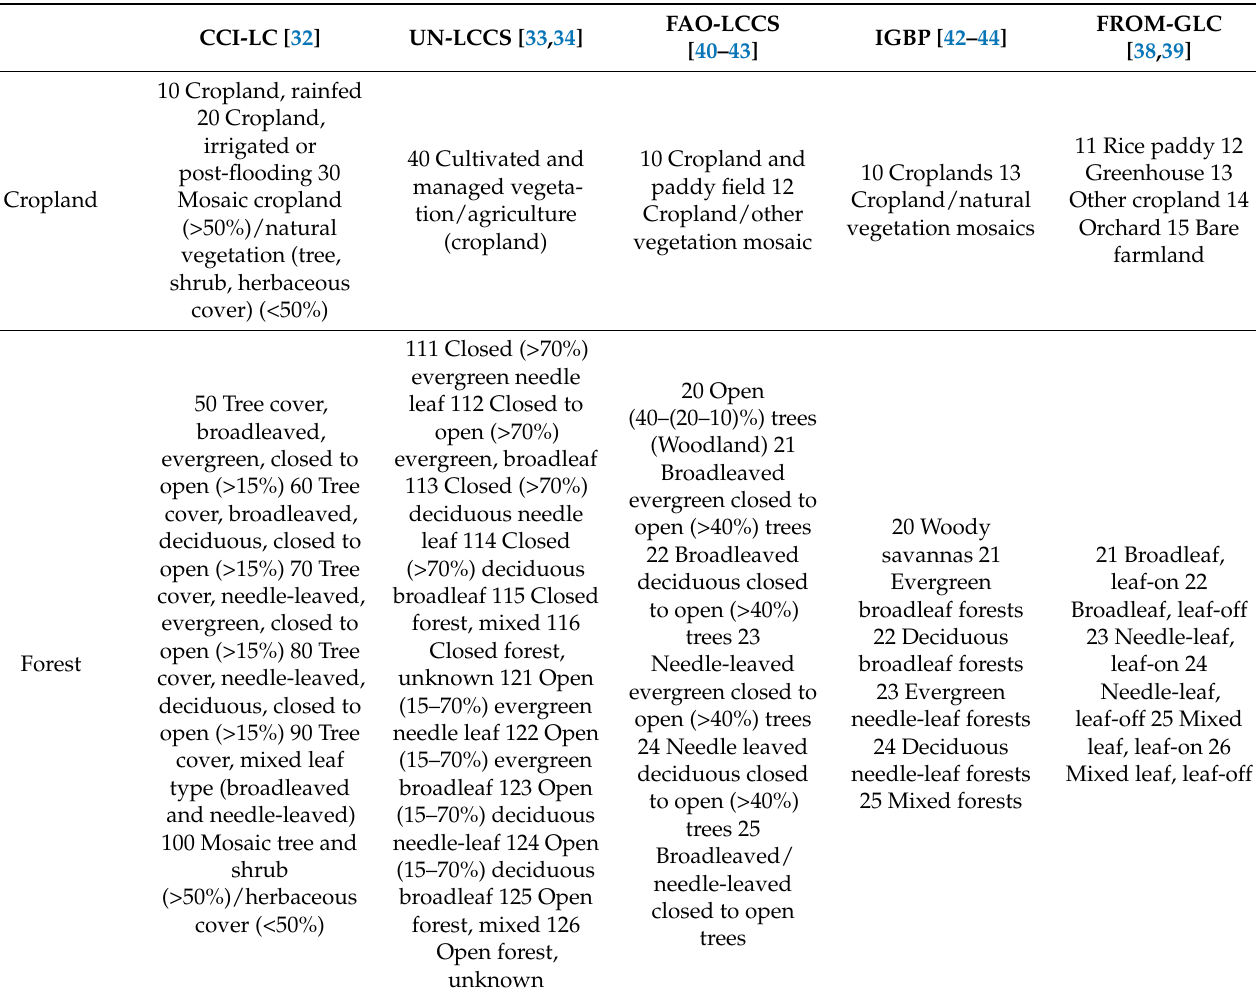
Table 2. Definition of landcover type in different landcover